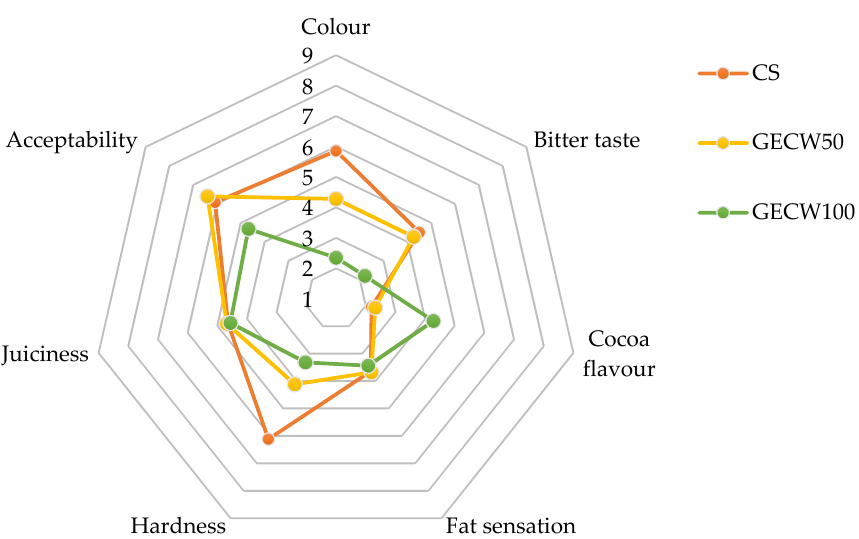
Figure 6. Sensory properties of cooked beef burger elaborated with cocoa bean shell flour and walnut oil emulsion gel as partial and total pork backfat replacers. CS: control sample elaborated with the traditional formula; GECW50: sample with 50% gelled emulsion elaborated with cocoa bean shell flour and walnut oil as fat replacer; GECW100: sample with 100% gelled emulsion elaborated with cocoa bean shell flour and walnut oil as fat replacer.